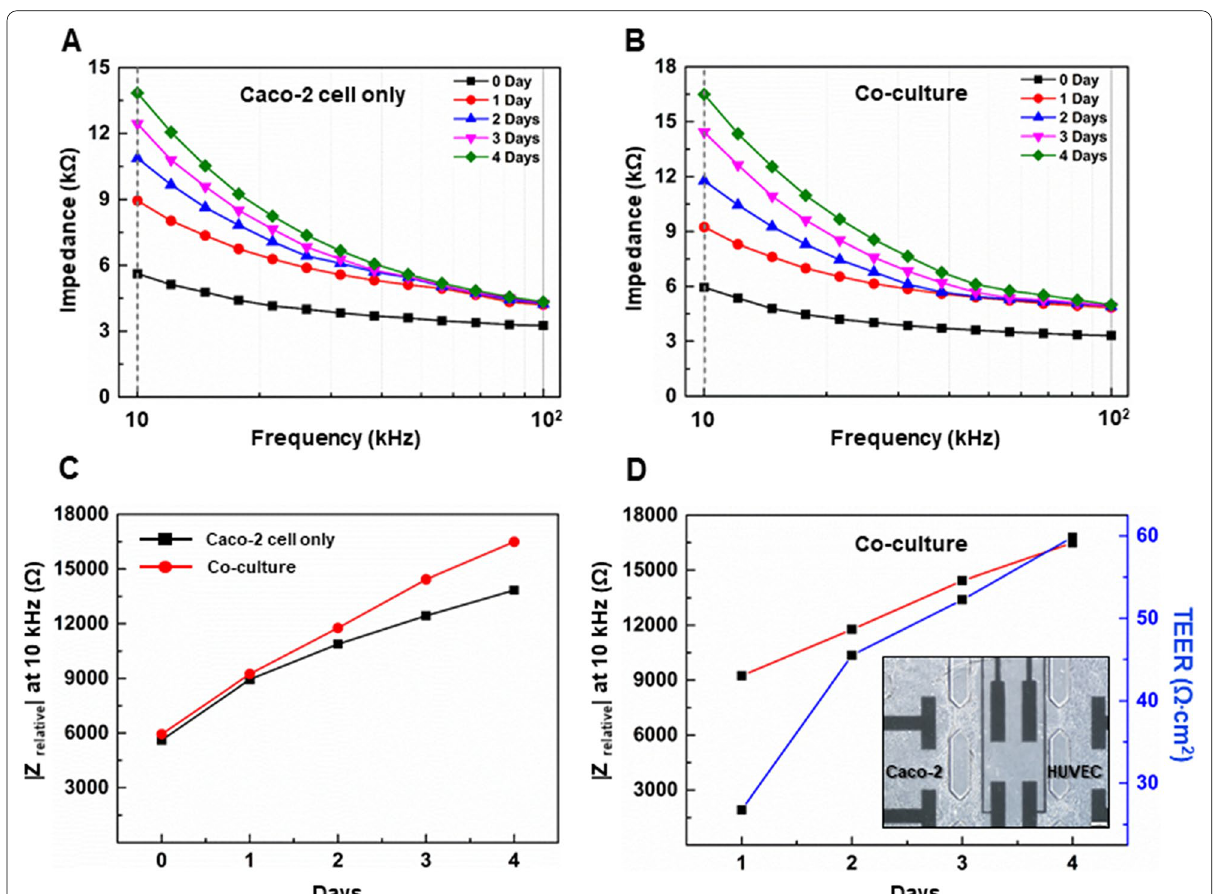
Fig. 5 Impedance analysis in a human gut‑on‑a‑chip. Impedance spectra showing the development of an intestinal epithelial barrier cultured with A Caco‑2 cell only and B co‑culture with Caco‑2 cells and HUVECs. C Epithelial resistance with respect to culture days, showing that the resistance of the co‑culture model was increased with culture days. D Epithelial impedance versus calculated TEER analysis in the co‑cultured